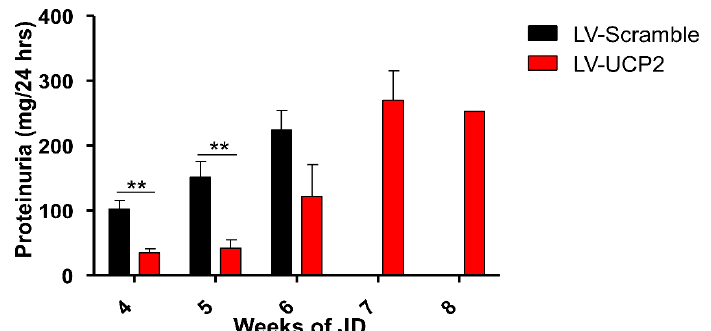
Figure 1. UCP2 brain delivery reduced renal damage in JD-fed SHRSP rats. Proteinuria levels in JD-